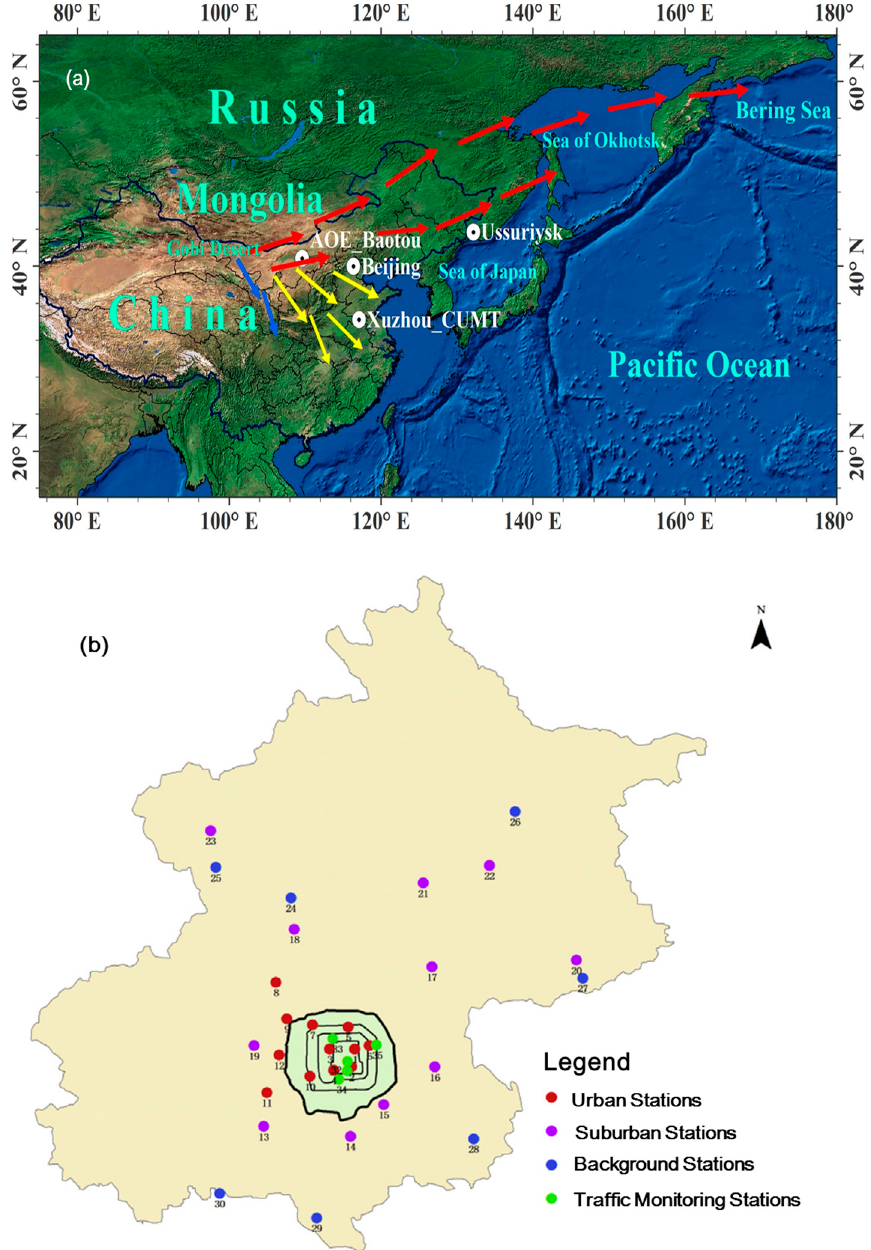
Figure 1. Transport path for dust event on May 2017 ( a ). The arrows show the dust transport directions, red arrows denote north-eastward transport, yellow arrows denote eastward transport, and blue arrows denote southward transport [16]. Location of air quality monitoring stations ( b ). Northern New Area stations is 8, and 9 is Beijing Botanical Garden station in Figure [39].